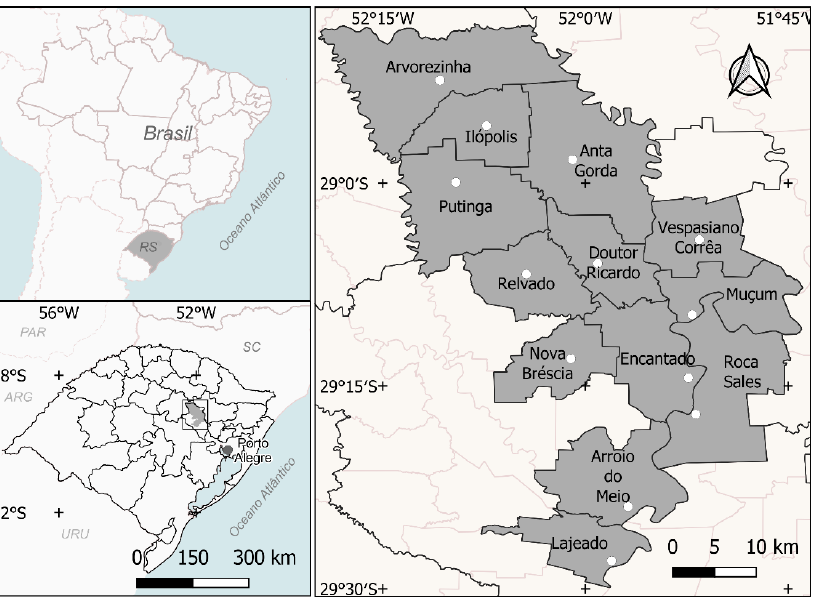
Figure 1. Location of the municipalities where the samples of colonial artisanal cheese were collected. The municipal data source was taken from the Brazilian Institute of Geography and Statistics (IBGE, 2021) and the map was modeled in QGIS 3.4 software. Low altitude references (<150 m): Arroio do Meio—AM (54 m), Encantado—EN (58 m), Lajeado—LJ (34 m), Muçum—MU (77 m), Roca Sales—RC (60 m); medium (>150 and <350): Nova Bréscia—NB (313 m), Relvado—RV (297 m);